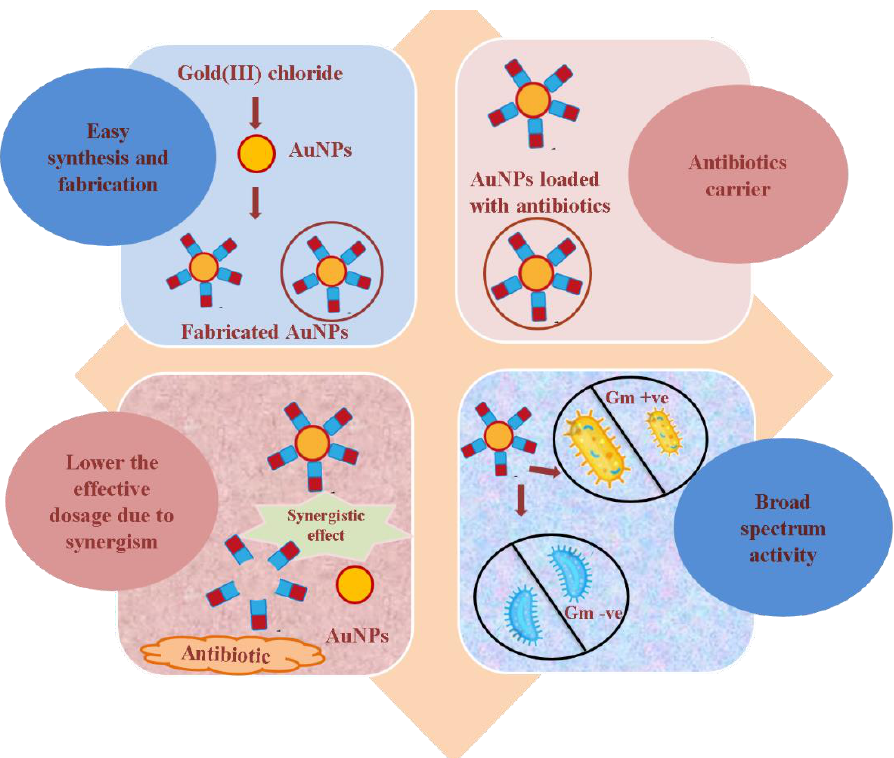
Figure 1. Advantages of AuNPs as a carrier of antibiotics.